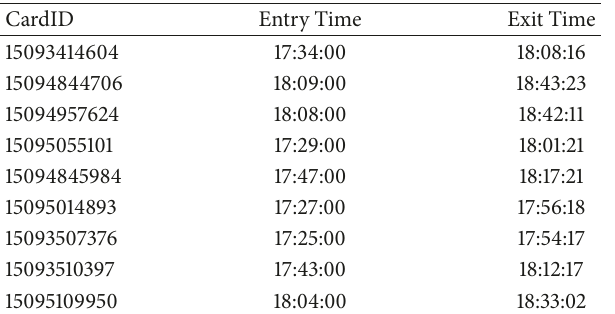
Table 3: AFC transaction data from Dongwuyuan to Chongwen- men. CardID Entry